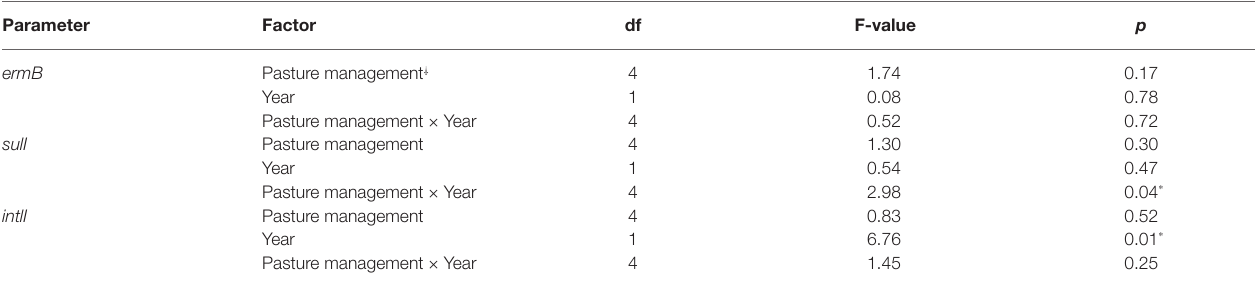
TABLE 3 | ANOVA results testing for differences in quantities of three AMR genes following poultry litter soil applications (runoff samples collected within 3 months) without control samples by pasture management, as well as the interaction between these two factors at Booneville, AR from 2018 to 2019. Parameter Factor df F-value p ermB Pasture management